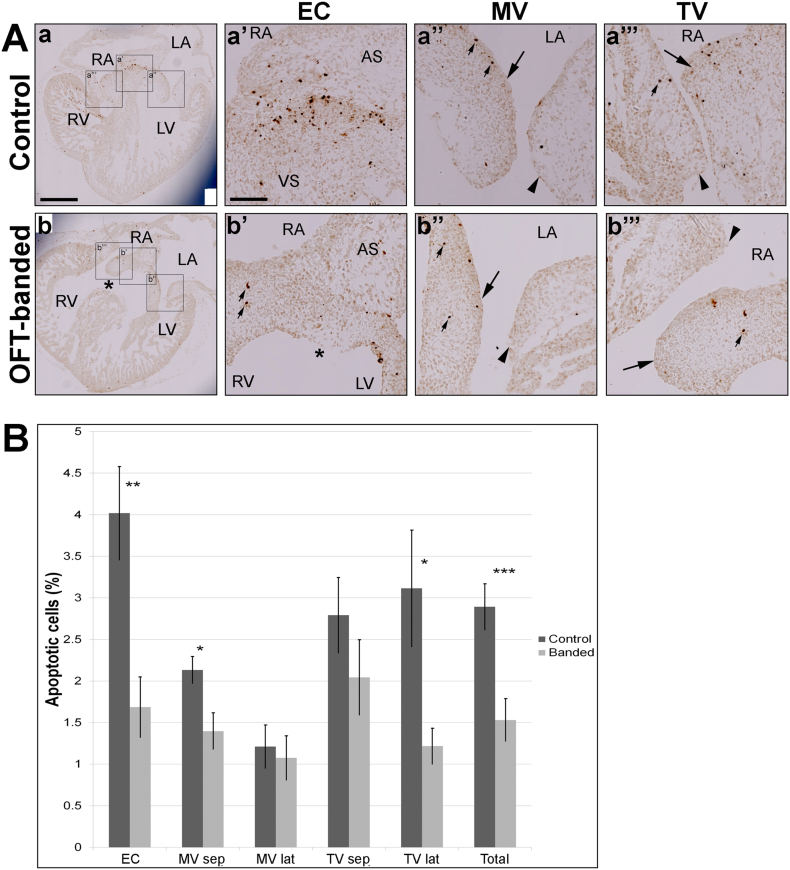
Apoptosis reduction in the primordial atrioventricular valve region of OFT-banded hearts.A. Apoptotic cells were detected by TUNEL in the endocardial cushion (EC), primordial MV leaflet and primordial TV valve leaflet (a & b). Clustering of apoptotic cells was identified in the EC area (area between atrial septum [AS] and ventricular septum [VS] in a’) in control, but few apoptotic cells in the EC area (between AS and asterix in b’; small arrows) in banded hearts. Otherwise, the apoptotic cells were found isolated and scattered (small arrows) in the primordial MV and TV (septal [denoted by arrow] and lateral leaflets [arrowheads] in both controls (a” and a”’) and banded (b” and b”’). Asterix in b and b’ denotes the ventricular septal defect in banded heart. Scale bar: 500 μm for Aa-b, 100 μm for Aa’–a”’ and Bb’–b”’.B. Apoptotic levels in sham and banded hearts at HH29. A decrease of apoptotic cells was shown in all areas analysed in primordial atrioventricular region (**P < 0.01). This was attributed to a significant decrease of apoptosis found in the EC (**P < 0.01), MV septal leaflet and TV lateral leaflet (*P < 0.05) in banded hearts compared to controls. No significant difference was found in the MV lateral leaflet and TV septal leaflet (P = 0.73 and P = 0.28 respectively). Student's t-test (two-tailed). Data indicate mean ± s.e.m. (n = 5).AS, atrial septum; EC, endocardial cushion; LA, left atrium; LV, left ventricle; MV, mitral valve; MV lat, mitral valve lateral leaflet; MV sep, mitral valve septal leaflet; RA, right atrium; RV, right ventricle; TV, tricuspid valve; TV lat, tricuspid valve lateral leaflet; TV sep, tricuspid valve septal leaflet; VS, ventricular septum.